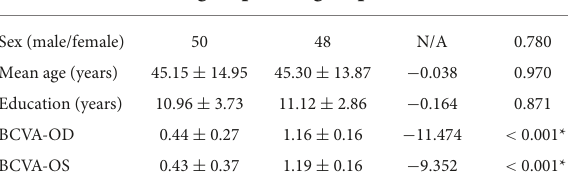
TABLE 1 Clinical information for two